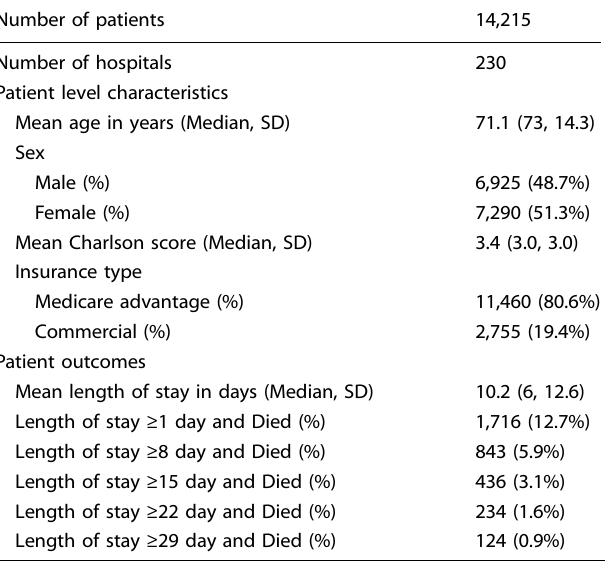
Table 1. Summary characteristics of the 14,215 patients from 230 hospitals in our